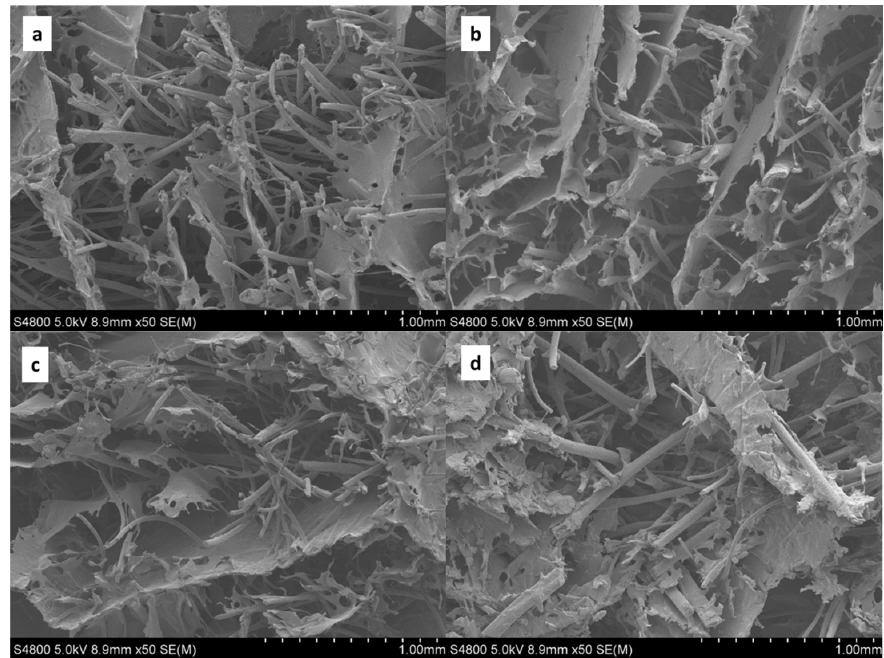
Figure 5. SEM micrographs with magnification of 1 mm for wool/SPI biocomposites: ( a ) SPI7, ( b ) SPI10, ( c ) SPI15, and ( d ) SPI20. Scale bar: 1.00 mm. ( b ) SPI10, ( c ) SPI15, and ( d ) SPI20. Scale bar: 1.00